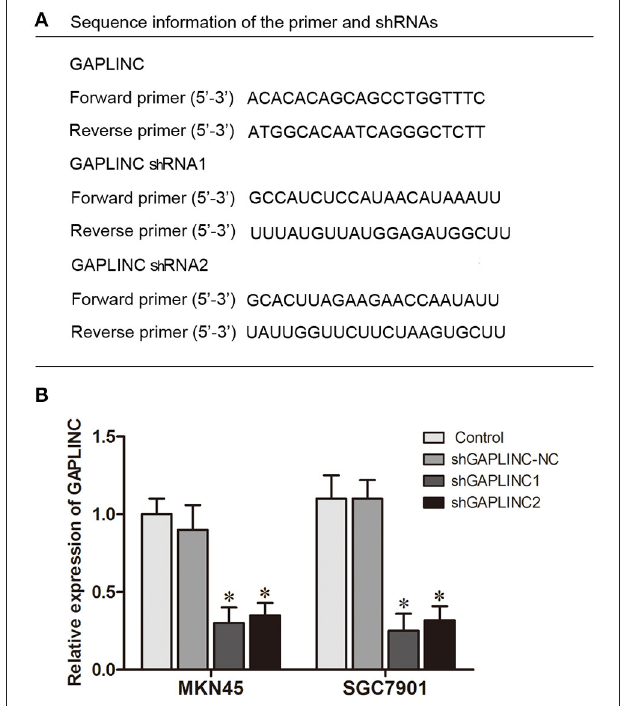
FIGURE 3 | Knockdown of GAPLINC with shRNAs. (A) Sequence information of the primers and shRNAs used. (B) Silencing efficiency of transfection using two shRNAs. The results were derived from at least three different experiments (* P <